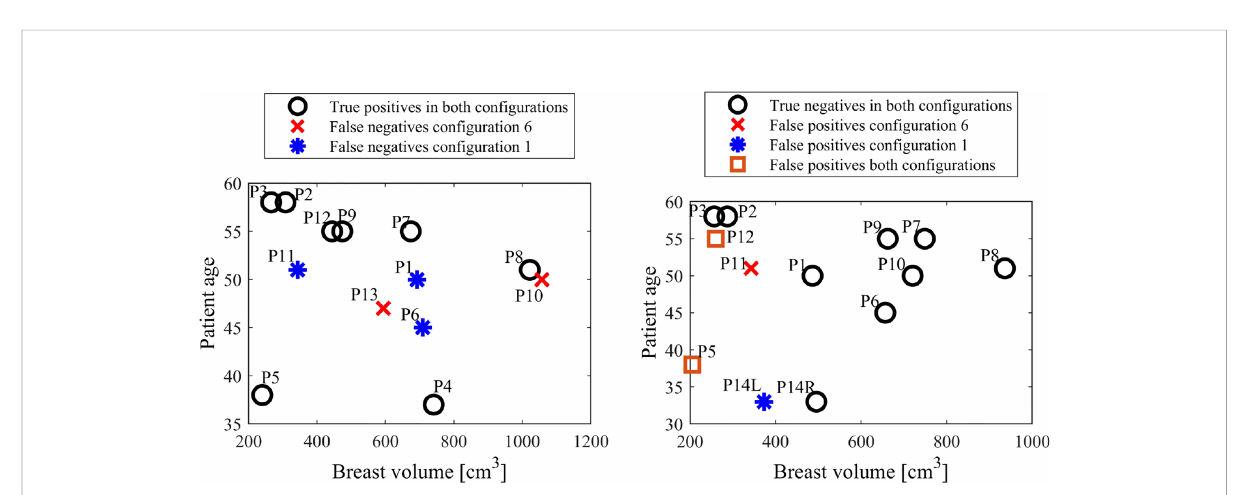
FIGURE 8 False negative (left) and false positive (right) ages and breast volumes for con fi gurations 1 and 6.